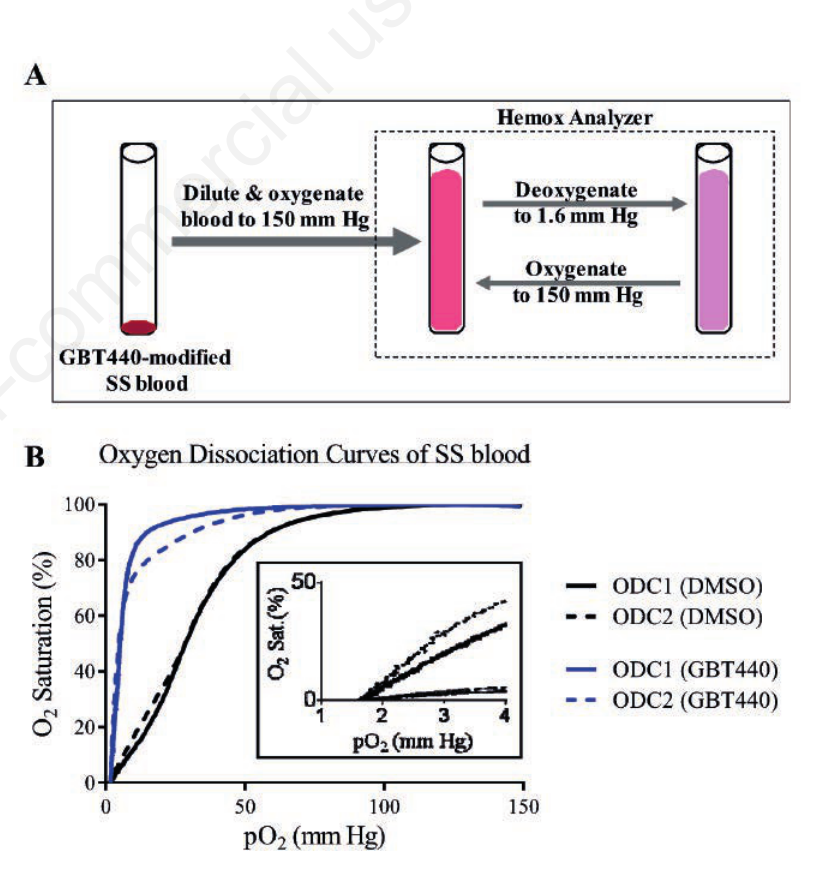
Figure 1. The GBT440/HbS interaction is maintained during cycles of oxygenation and deoxygenation. (A) Schematic representation of deoxygenation and oxygenation cycles of GBT440-modified sickle cell blood in Hemox Analyzer. (B) Oxygen dissociation curves of sickle cell blood (at 20% hematocrit containing~ 1 mM hemoglobin) modified with GBT440 (1